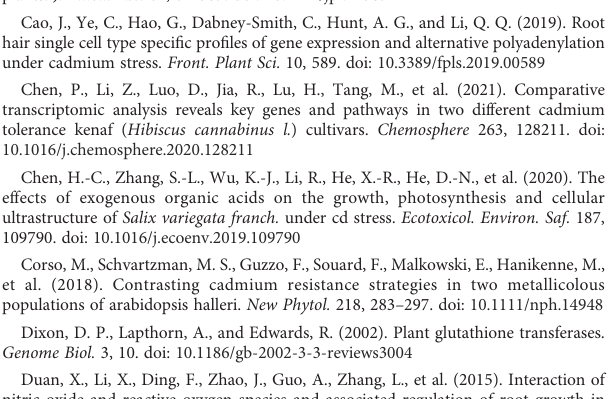
SUPPLEMENTARY TABLE 3 GO analysis of